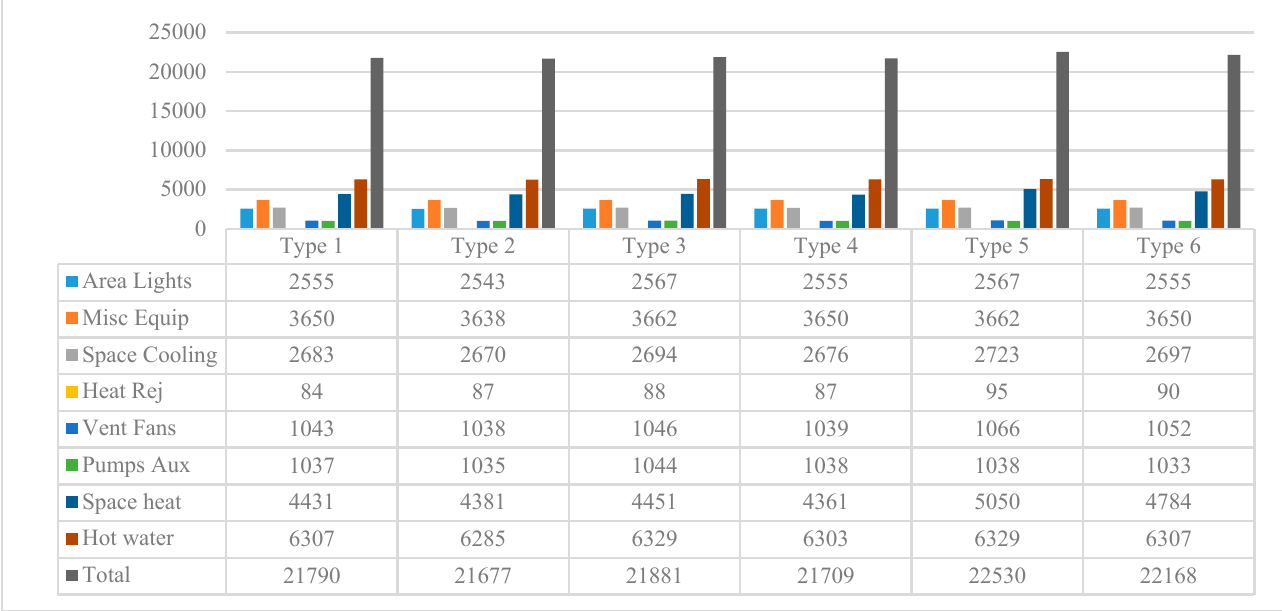
Figure 11. The energy use intensity values of the designed building types with insulation material and without insulation material. Energy usage intensity (EUI) is a parameter calculated by dividing the annual build- ing energy consumption by the total gross floor area and characterizes the energy use of a building in terms of its function, size, and other characteristics [74]. Among the six wall types, the minimum energy-use intensity was as 1026.1 kWh per m 2 for Type 2. The high- est energy-use intensity was 1115.5 kWh per m 2 for Type 5. Among walls without insula- tion, the minimum and maximum energy-use intensity values found were 1291.1 kWh per m 2 and 1666.6 kWh per m 2 for Type 1–2 and Type 5–6, respectively. 4. Conclusions Fast technological improvements and a growing population lead to increases in power consumption despite the environmental consequences. In Turkey, 34 percent of the total power usage takes place in service and residential buildings. In this research, the life- cycle cost method was utilized to optimize the thermal insulation thickness of building envelopes for energy efficiency. The expenses of insulating materials differ based on the material type. Furthermore, the wall structure, degree-days, and insulating material all have an important effect on the optimum insulating thickness. It is possible to increase or decrease the energy performance by changing the wall structure. In this paper, the opti- mum insulation thickness for a 10-year lifetime is calculated along with annual heating